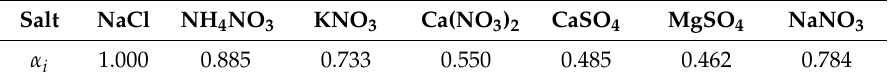
Table 8. Equivalent salt deposit density ( ESDD ) contribution ratio of soluble constituents.